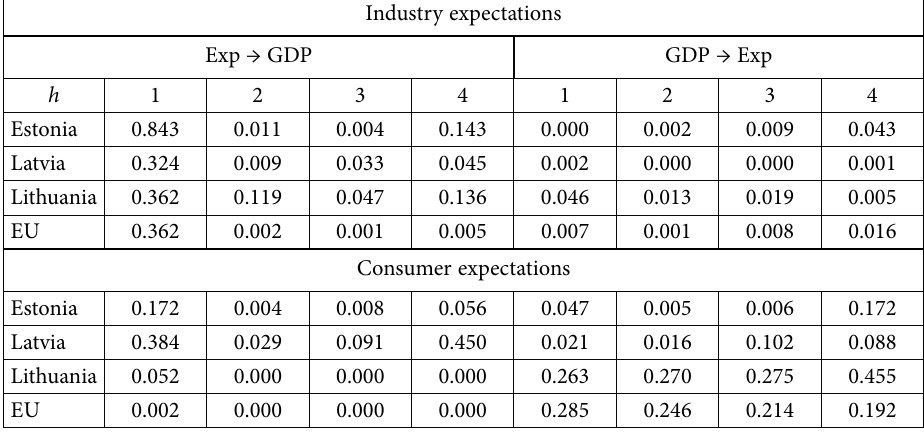
Table 4. Granger causality